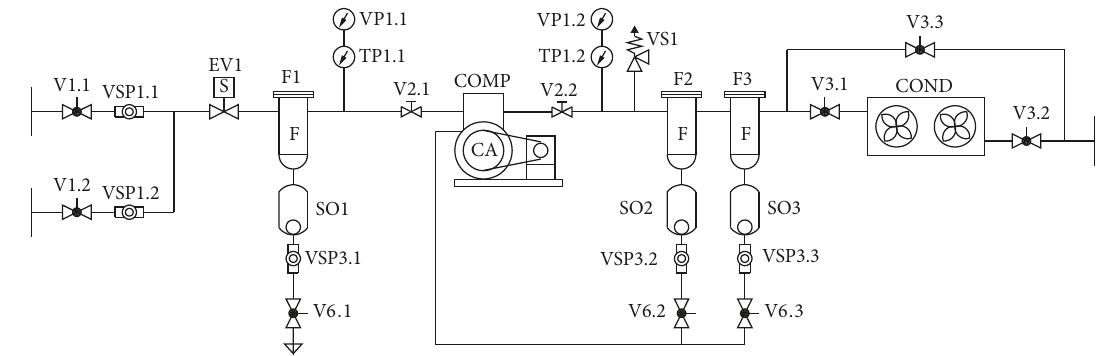
Figure 1: Experimental plant for refrigerant gas recovery.